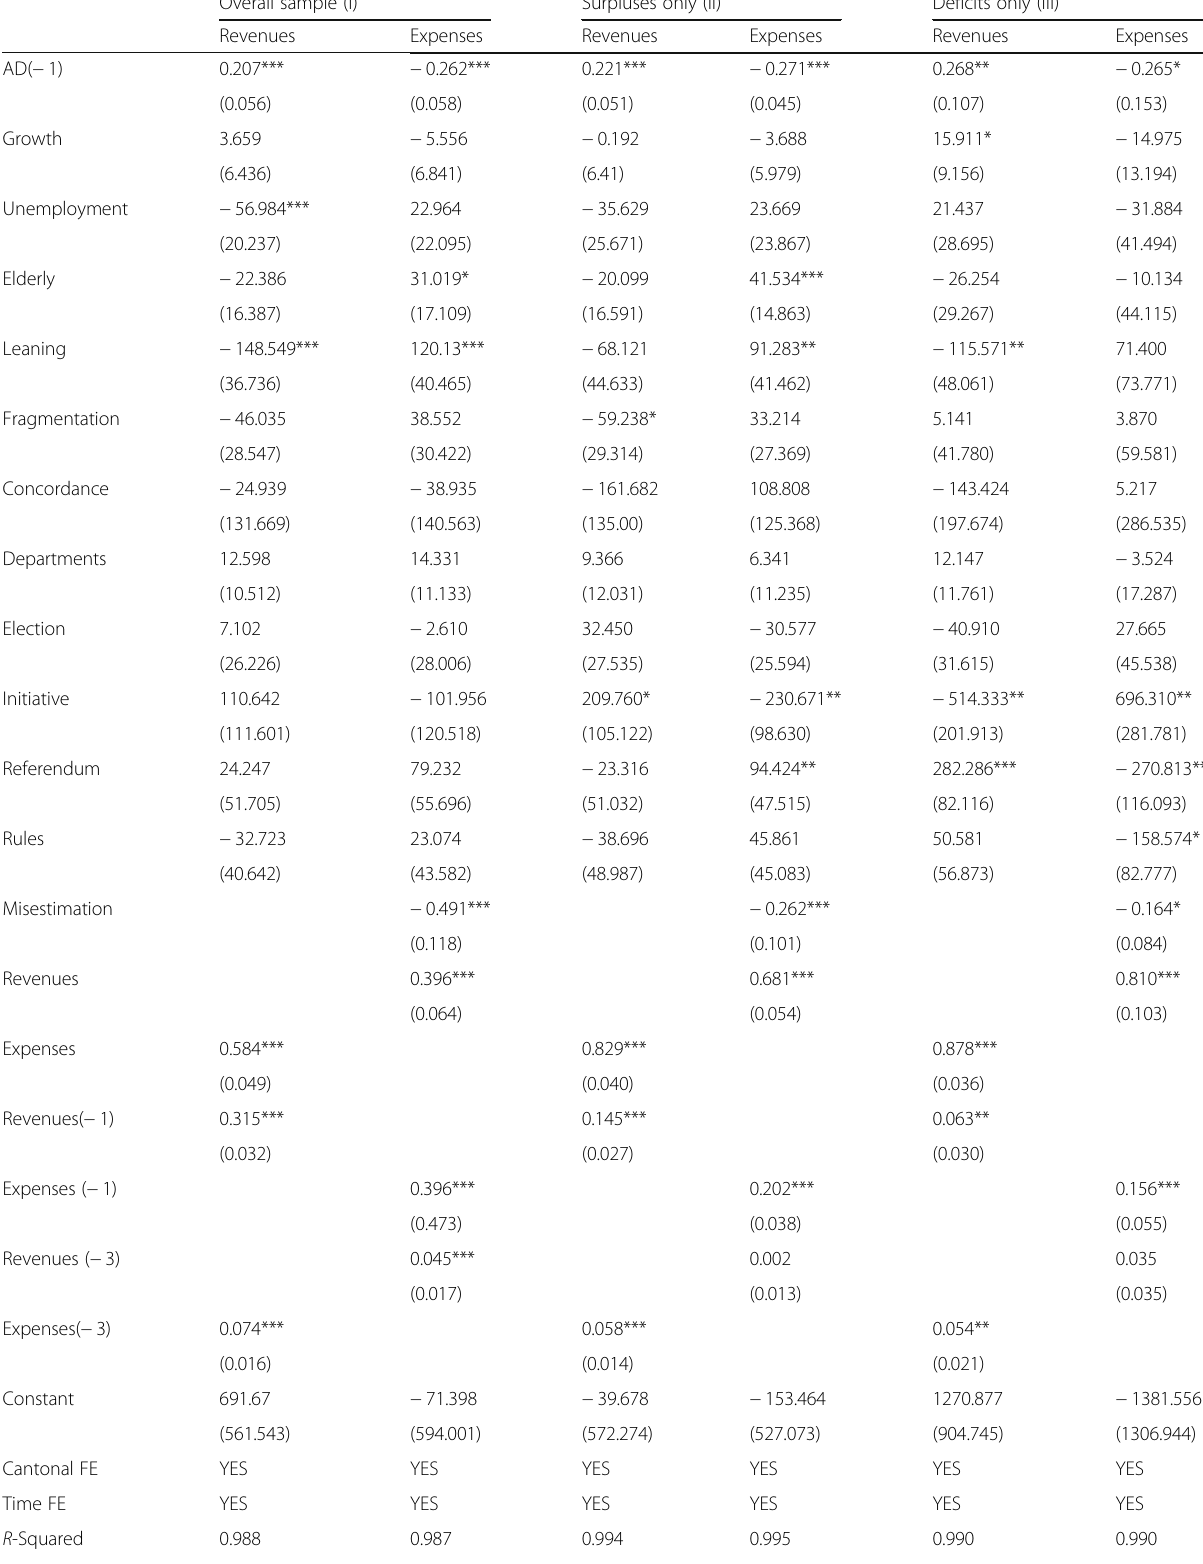
Table 3 Results for the simultaneous-equations